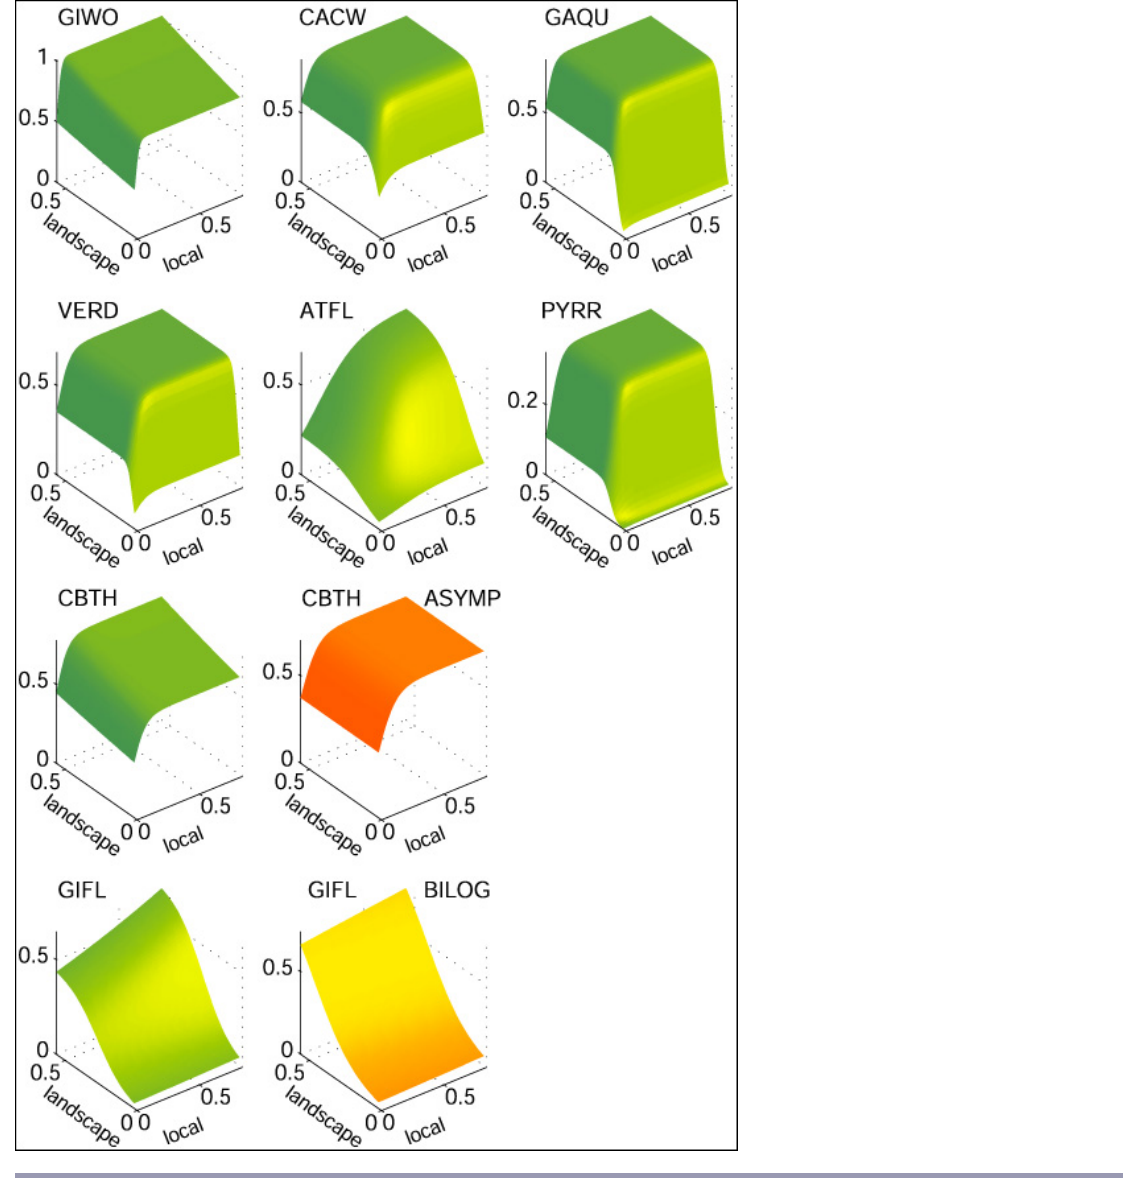
Fig. 5 . Fitted response surfaces for all 8 desertscrub study species under the best models. Green surfaces are predictions of the constraint model M for each species, and orange surfaces are predictions CONSTRAINT of the best model for the two cases in which another model outperformed M . Lower-right axis CONSTRAINT in each graph: x , the proportion desertscrub cover within 56 m, i.e., local scale. Lower-left axis: x , 1 2 proportion desertscrub cover within 1784 m, i.e., landscape scale. Vertical axis: per-site occurrence probability. For visual clarity, vertical axis scaling varies among species according to maximum predicted occurrence probability. Scaling of two horizontal axes remains constant. Four-letter codes identify species; see Table 1 for species names. ASYMP and BILOG represent the asymptotic and bivariate logistic models,